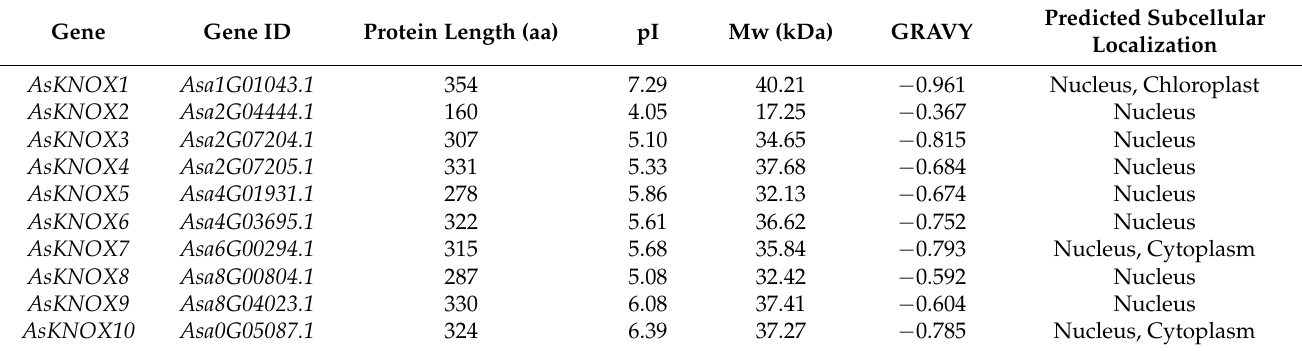
Table 1. Information of 10 AsKNOX gene homologs in garlic